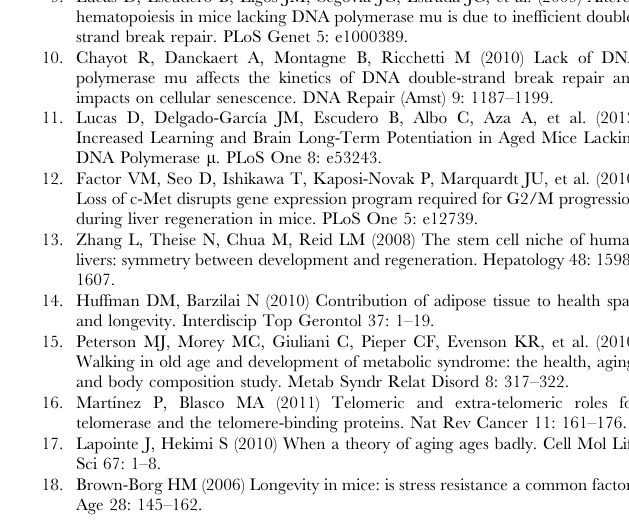
Table S2 Oligonucleotides used for qRT-PCR